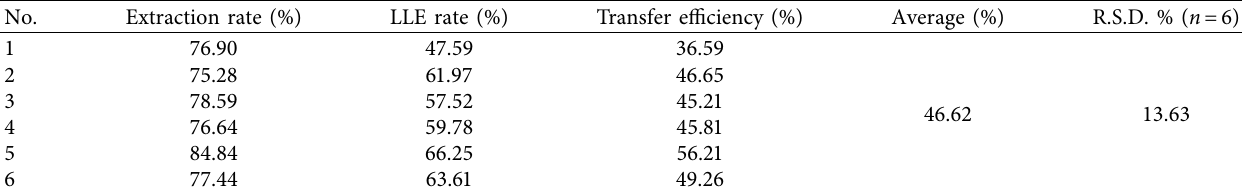
Table 7: Calculation of transfer efficiency. The transfer efficiency is the product of the extraction rate and the LLE rate.